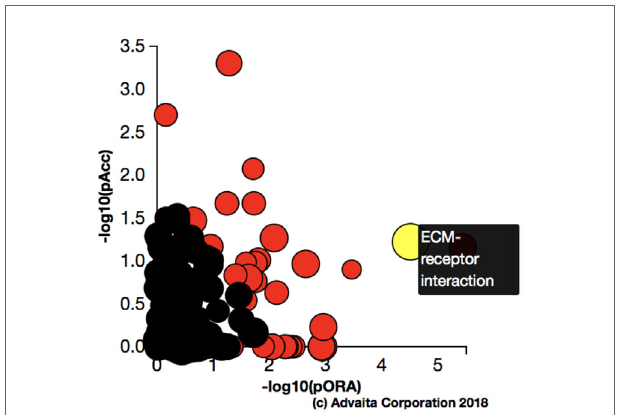
FigUre 5 | Pathway impact analysis. Using Illumina’s iPathwayGuide, we identified the biological pathways with the most significant perturbation and overrepresentation combination. Extracellular matrix (ECM) receptors interactions pathway was the most significantly